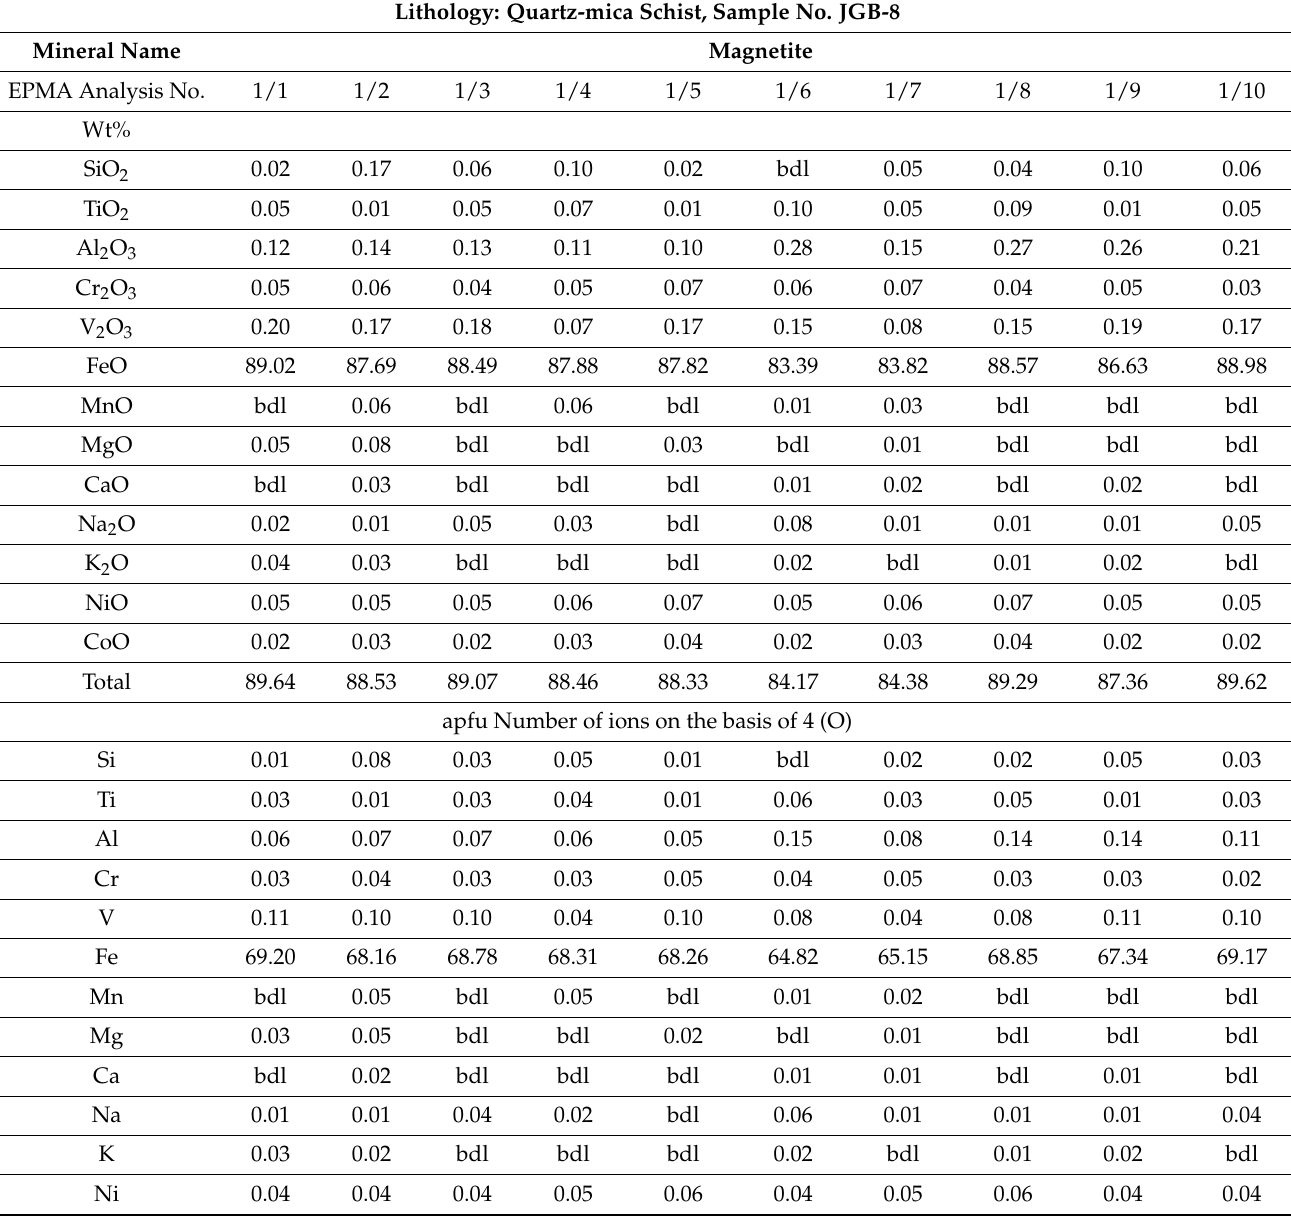
Table 2. EPMA data of magnetite from the Jagpura gold-copper deposit, western India. Lithology: Quartz-mica Schist, Sample No.